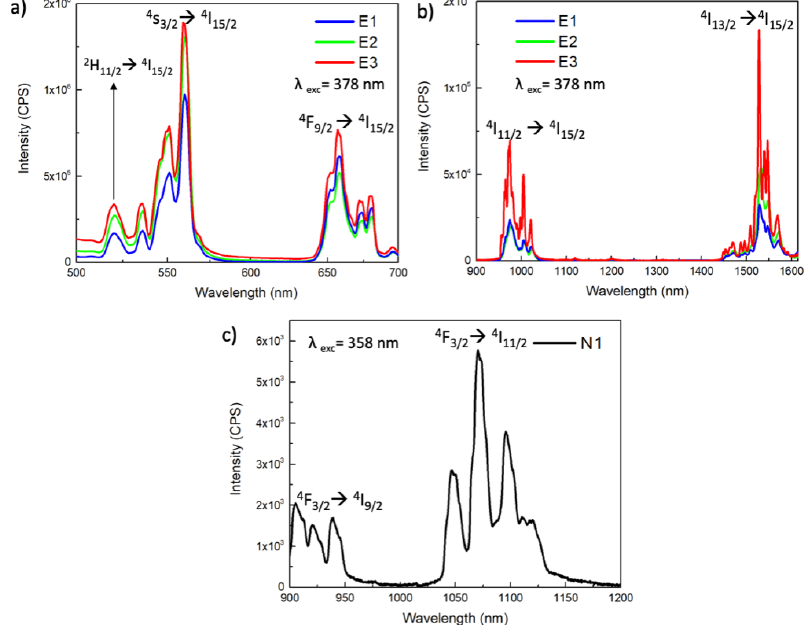
Figure 4. PL emission spectra of Er:Y 2 O 3 NPs samples E1, E2 and E3 in the visible ( a ) and IR ( b ) range ( λ exc = 378 nm). ( c ) PL emission spectrum of the Nd:Y 2 O 3 NPs sample. N1 ( λ exc = 358 nm).